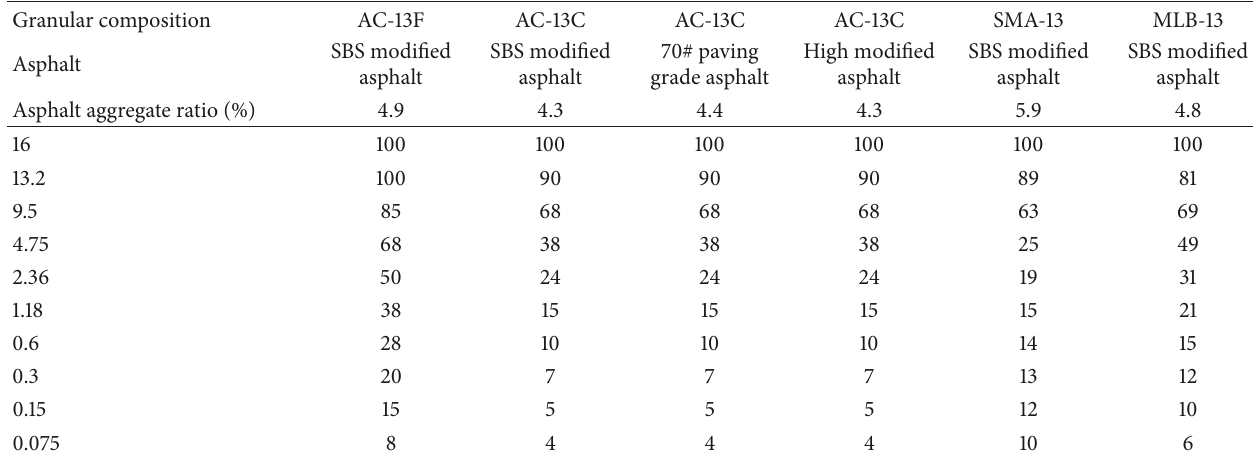
Table 2: Mix design information of asphalt mixtures.